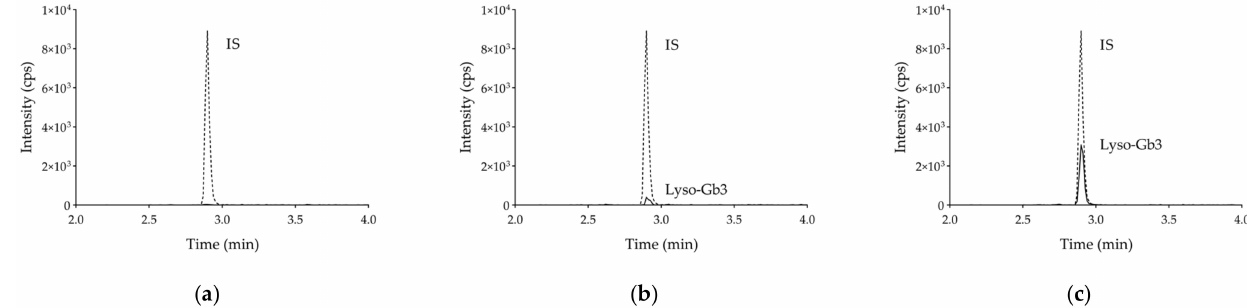
Figure 1. Chromatograms obtained by injecting 10 µ L of: ( a ) blank plasma spiked with internal standard; ( b ) blank plasma spiked with lyso-Gb3 at LLOQ (0.25 ng/mL) and internal standard; ( c ) plasma sample of a FD patient spiked with internal standard.